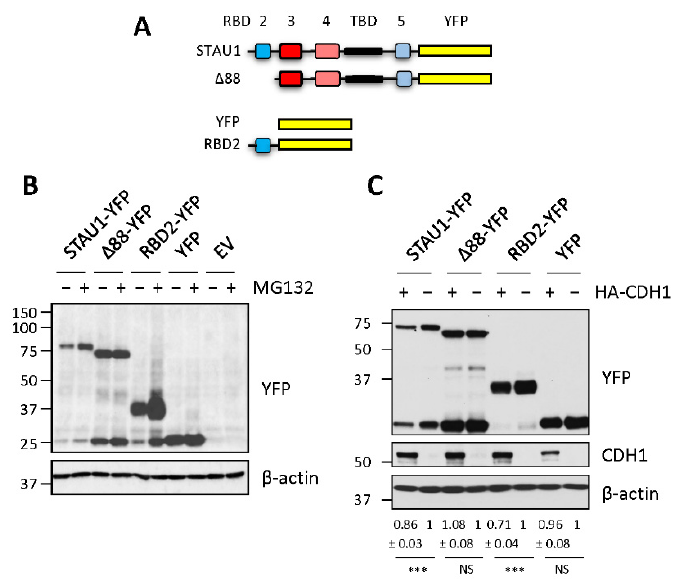
Figure 1. RBD2 is sufficient to induce degradation of STAU1 55 by APC/C-UPS. ( A ) Schematic representation of STAU1 55 -YFP and the deletion mutants. STAU1, STAU1 55 ; ∆ 88, STAU1 55 lacking the first N-terminal 88 amino acids; RBD2, RNA-binding domain 2 corresponding to the first N- terminal 88 amino acids of STAU1 55 ; YFP, yellow fluorescent protein. Red boxes, RNA-binding domains (RBD); blue boxes, regions with RNA-binding consensus sequence but lacking RNA-binding activity in vitro; yellow boxes, YFP; black boxes, tubulin-binding domain (TBD). ( B ) HEK293T cells expressing STAU1 55 -YFP, deletion mutants, YFP, or an empty vector (EV) were grown in the presence (+) or absence ( − ) of the proteasome inhibitor MG132 for 8 h. Protein extracts were analyzed by Western blotting. ( C ) HEK293T cells were cotransfected with plasmids coding for HA-CDH1 (+) or an empty vector ( − ) and plasmids coding for STAU1 55 -YFP, STAU1 Δ 88 -YFP ( Δ 88-YFP), RBD2-YFP, or YFP. Degradation of the proteins in the presence (+) or absence ( − ) of HA-CDH1 was observed by Western blotting. Western blots using anti-CDH1 antibody confirm the expression of HA-CDH1. The blots are representative of three independently performed experiments that gave similar results. The ratio of the amounts of the expressed proteins to that of actin in the absence or presence of HA-CDH1 was calculated, and the ratio in the absence of HA-CDH1 was arbitrarily fixed to 1. The numbers represent the means ± standard deviation of the relative amounts of the proteins in three independently performed experiments. ***, p -value ≤ 0.001 (Student t -test). NS, not significant.